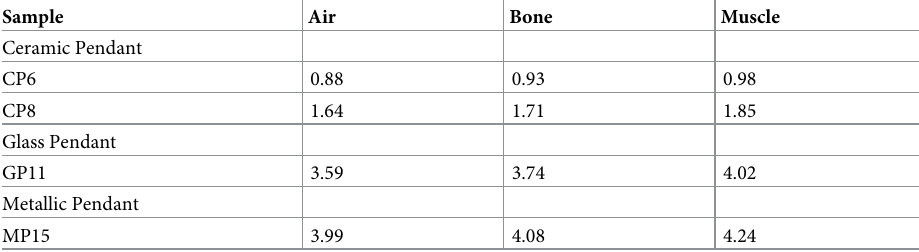
Table 3. Annual dose (in mSv/y) due to U-238, Th-232 and K-40, obtained using the HPC program.